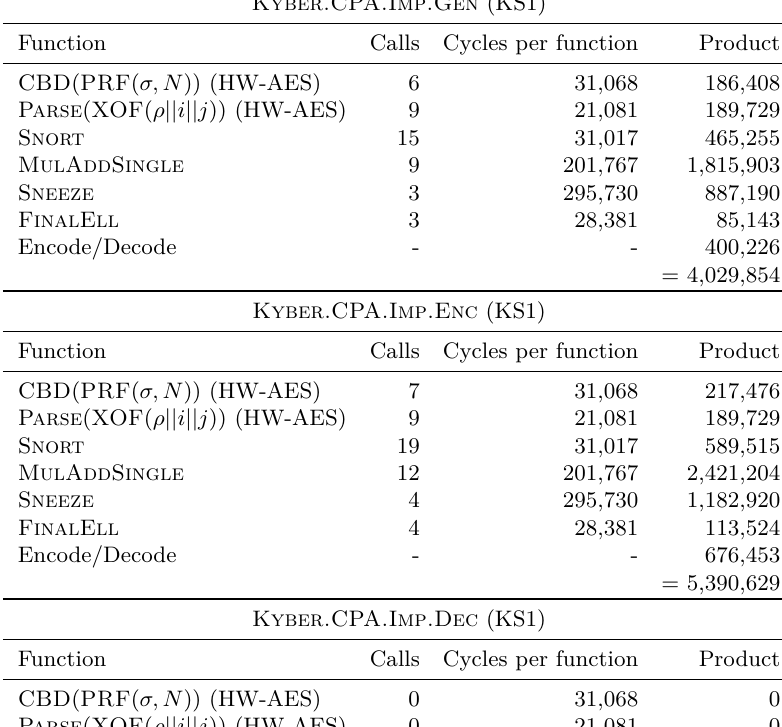
Table 3: Called functions, number of calls, clock cycles, and final sum of clock cycles. Kyber.CPA.Imp.Gen (KS1)